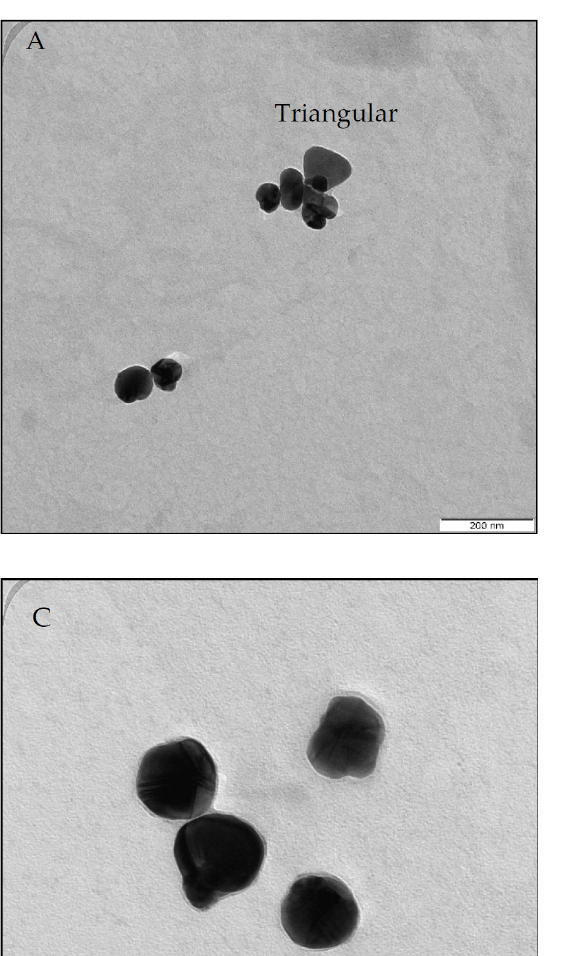
Figure 1. Observation of the LSPR band at different incubation times (0 h (nil), 24 h (441 nm), 48 h (443 nm), and 72 h (445 nm)) confirmed the formation of bioAgNPs. Inset: color changes after incu- bation for 24 h (light yellow), 48 h (light brown), and 72 h (brown). No color change was observed for the control solution after 72 h of incubation.